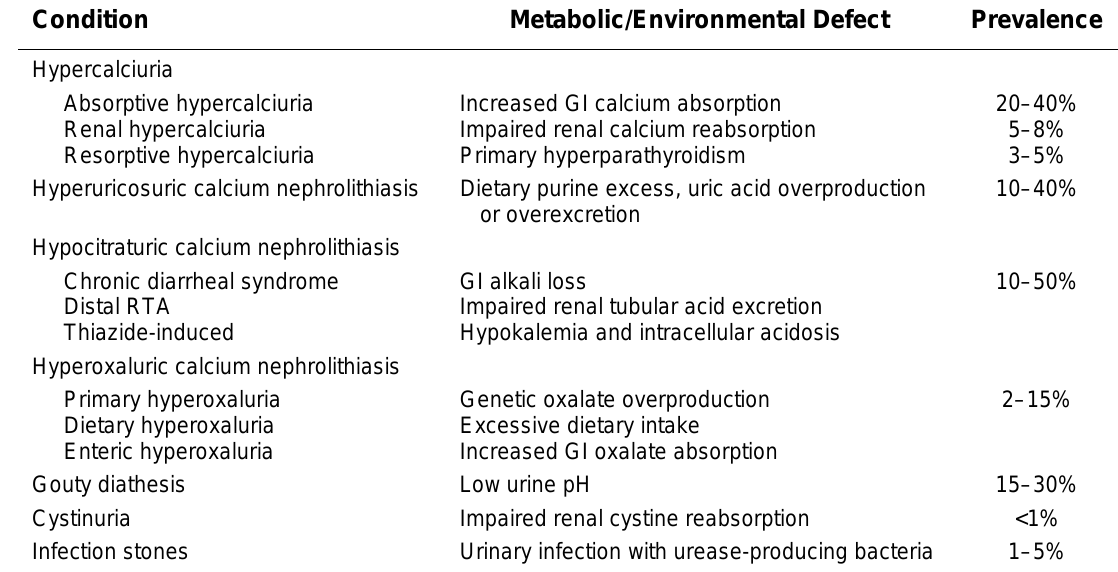
Classification of